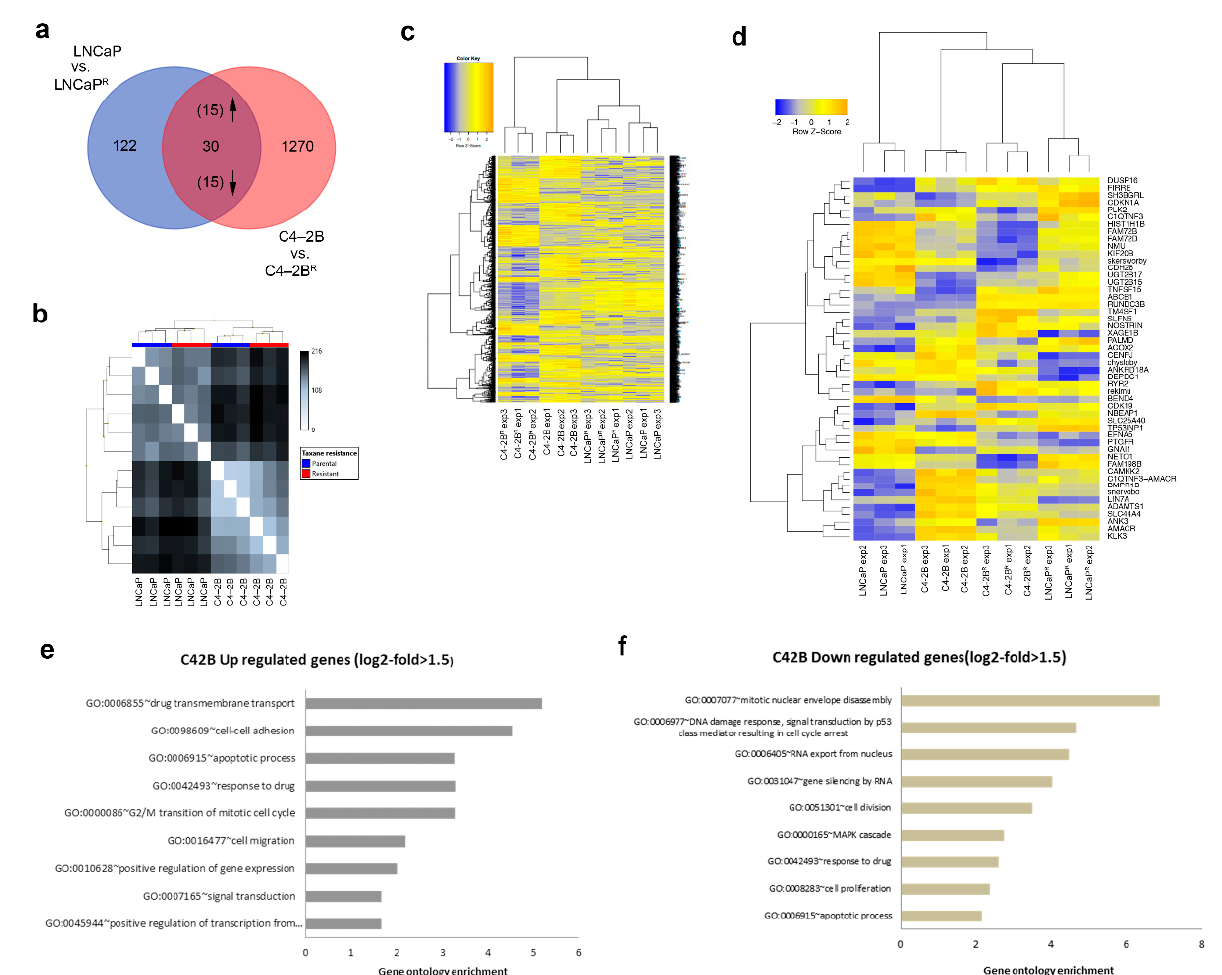
Figure 2. Gene expression analysis of docetaxel-resistant cells. ( a ) Venn diagram showing the number of differentially expressed genes in the docetaxel-resistant lines compared to the parental lines. Only genes with at least 1.5-fold change in expression levels between the parental and docetaxel-resistant cells ( p ≤ 0.05) were selected. ( b ) Distance matrix graph of analyzed samples. Distance between two samples was calculated using Euclidean metrics. ( c ) Heatmap of the 1300 genes that are significantly differentially expressed between parental and C4-2B R docetaxel-resistant cells and the 152 genes differentially expressed between parental and LNCaP R resistant cells. ( d ) Heatmap including only the genes that are differentially expressed by both LNCaP R and C4-2B R resistant cells. Heatmap visualization was performed using the gplots package in R. The intensity of the squares reflects the fold repression (blue) or fold induction (orange), according to the color scale at the top. ( e , f ) Selected Gene Ontology (GO) categories for the C4-2BR cell line genes, for ( e ) up- and ( f ) down-regulated genes.